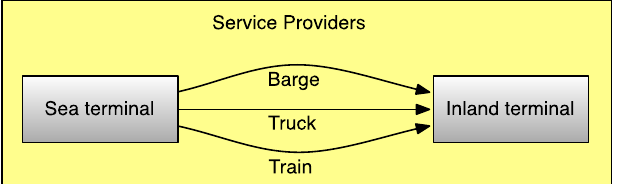
Figure 6. Role of service providers in the synchromodal transport